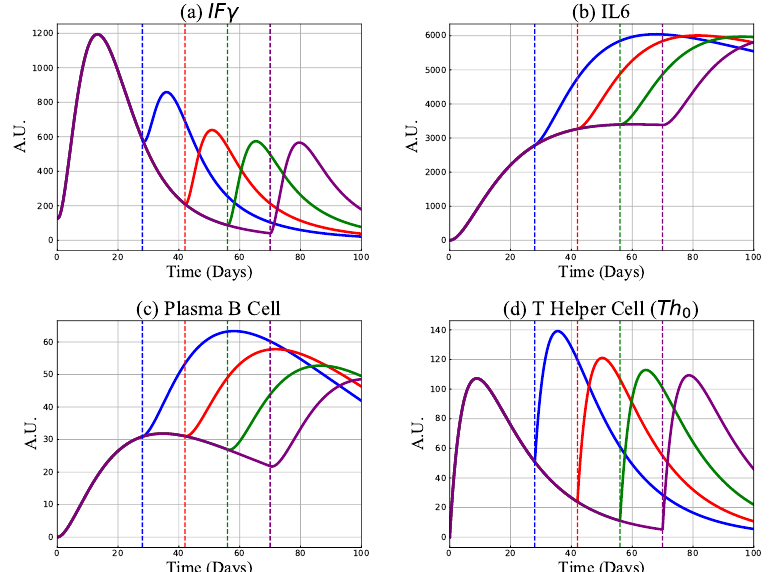
Figure 5. Model predictions of IFN γ , IL-6, plasma B-cells and T helper type 0 cells Th 0 for the received boost dose (1000 vaccine particles) on days 28 (blue curve), 42 (red curve), 56 (green curve) and 70 (purple curve). The vertical dashed lines show the second dose injection